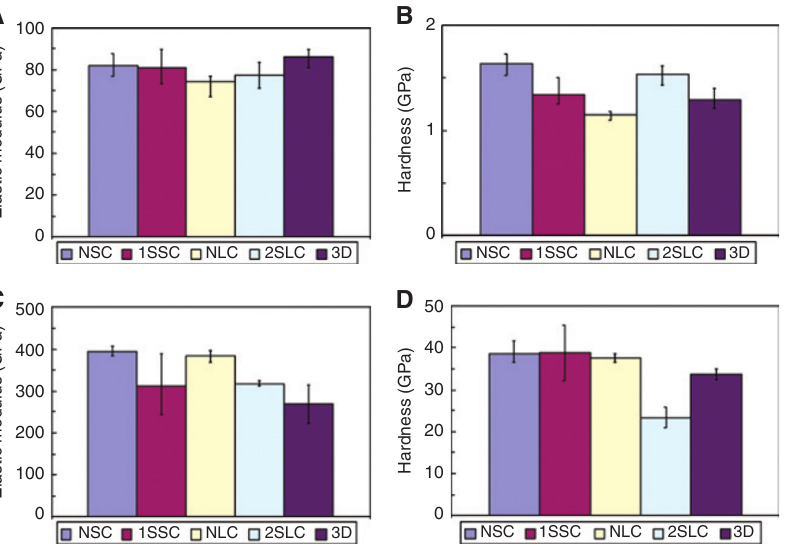
Figure 11 Nano-indentation hardness and elastic modulus results obtained from the matrix (A and B) and particle (C and D) regions incor- porated in the various Al